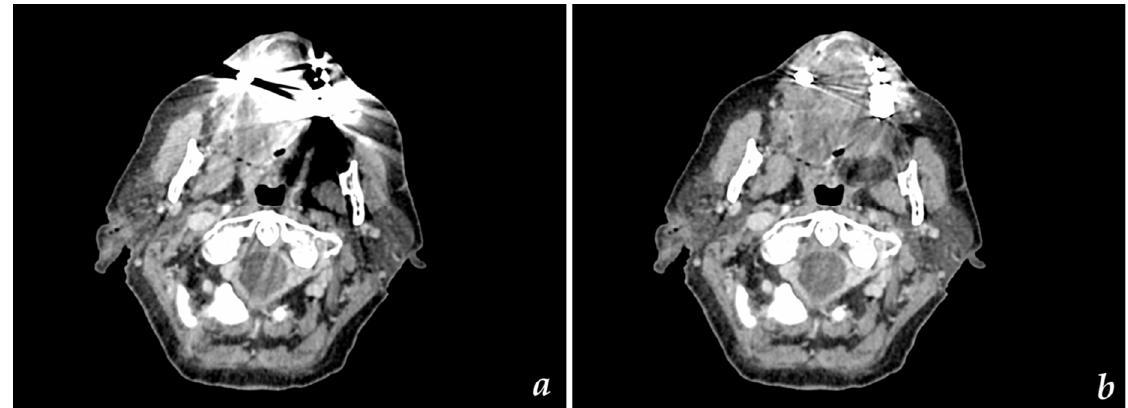
Figure 2. Axial CT images with ( a ) AIDR reconstruction and ( b ) SEMAR reconstruction illustrating greater homogeneity of the SEMAR dataset and significant reduction of metal artifacts.